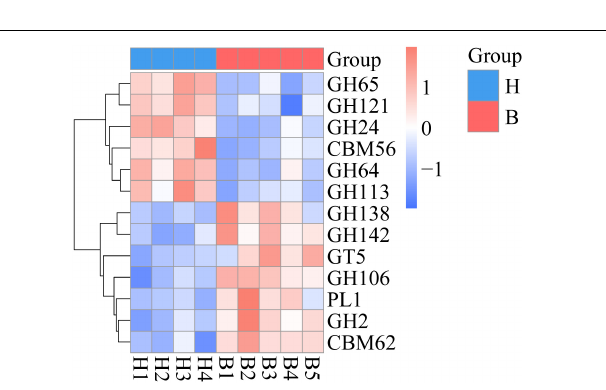
FIGURE 6 | Metastats analysis in the second classification level of the CAZy